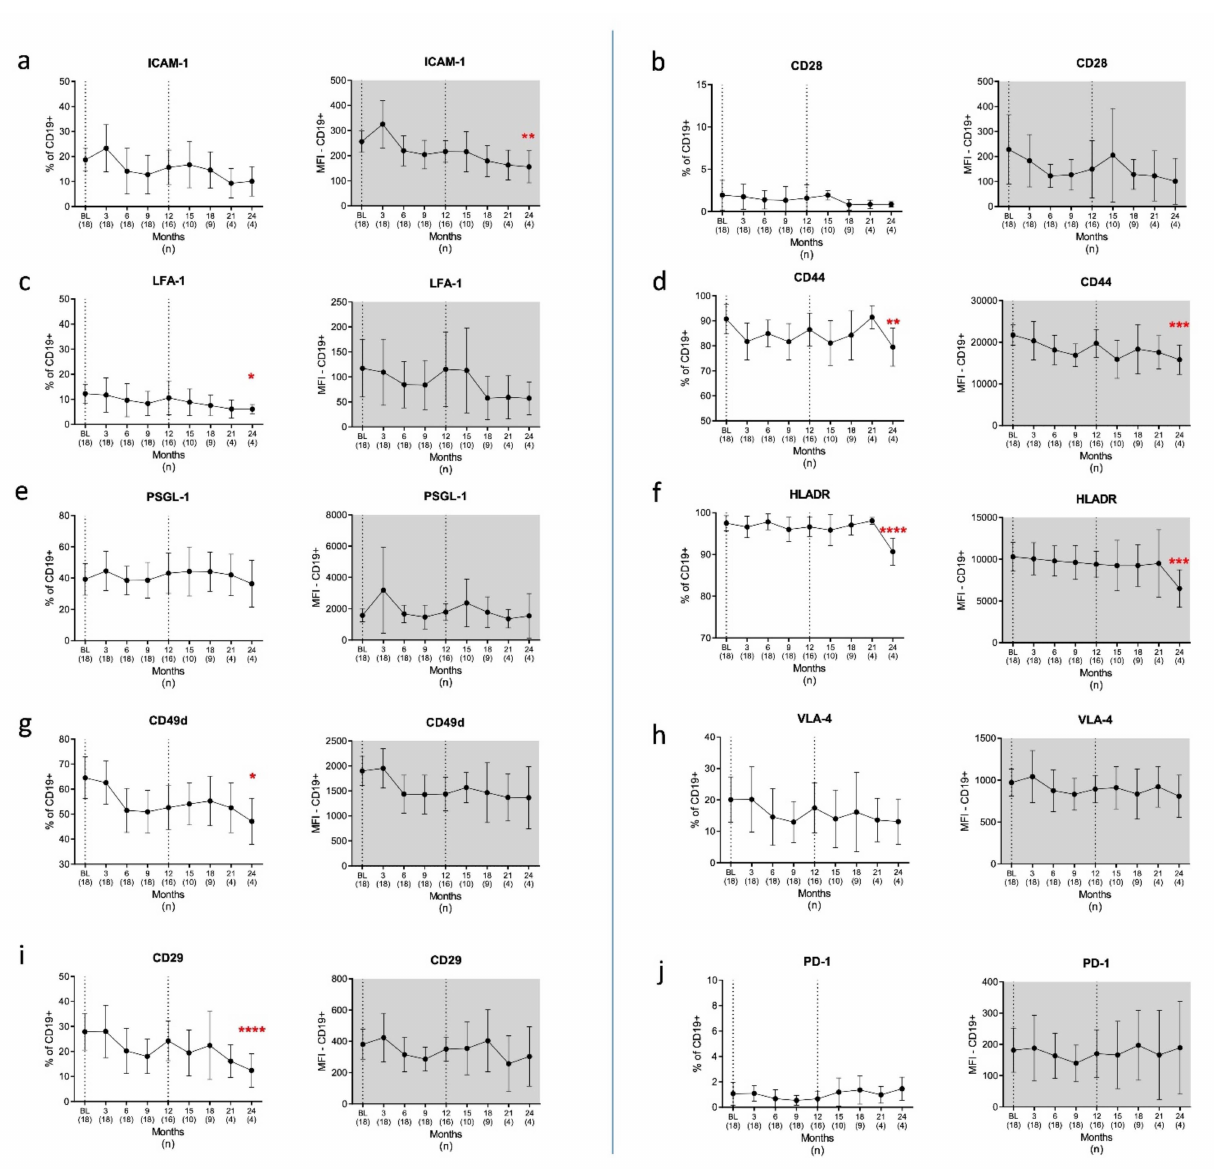
Figure 3. Adhesion and costimulatory surface proteins on B cells/CD19+ ( a – j ). Proportions of B cells expressing CAMs and CoSs (white graphs) as well as the intensity of expression (MFI) of positive cells (grey graphs) were evaluated by flow cytometry over a period of 24 months. We found decreased surface densities for ICAM-1 ( a ), CD44 ( d ) and HLADR ( f ) on B cells and a reduced frequency of B cells expressing LFA-1 ( c ), CD44 ( d ), HLADR ( f ), CD49d ( g ), and CD29 ( i ) at 24 months after CLAD initiation. Legend: BL = baseline; n = number of patients included at each time point. Data are shown as mean values ± SD. * p ≤ 0.05, ** p ≤ 0.01, *** p ≤ 0.001 and **** p ≤